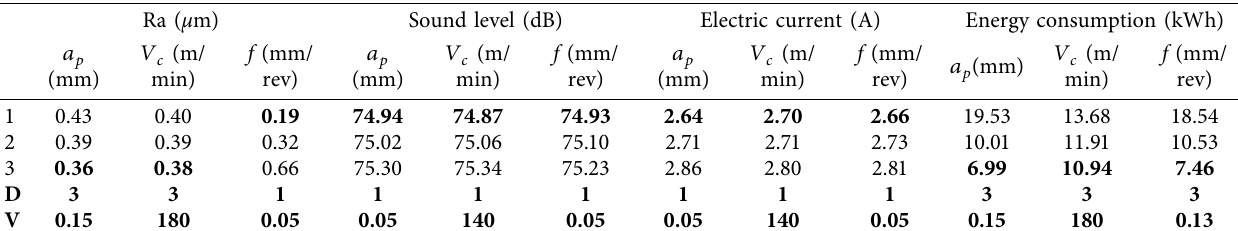
Table 10: Optimum cutting parameters level (D) and value (V) for surface roughness (Ra), electric current, sound intensity level, and energy